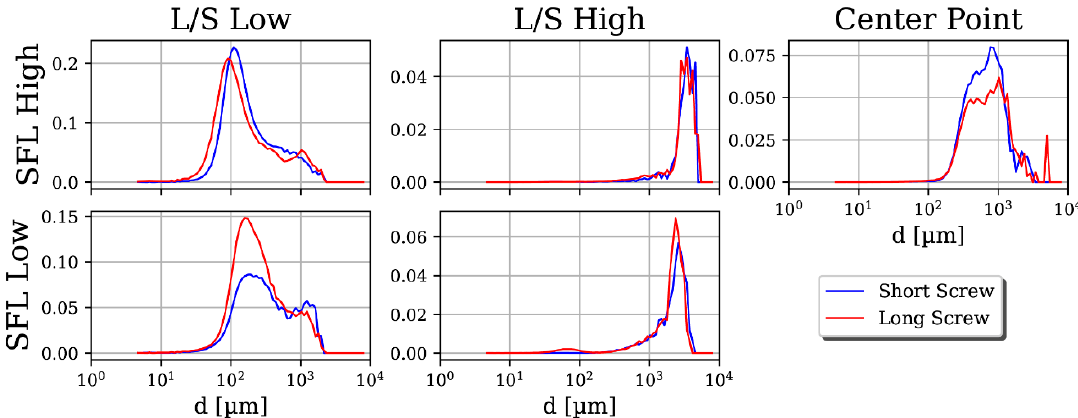
Figure 3. Volumetric probability density size distributions (q 3 ) in a long and short screw setup for all combinations of low and high specific feed load (SFL) and liquid-to-solid ratio (L/S) parameters as well as a center point.